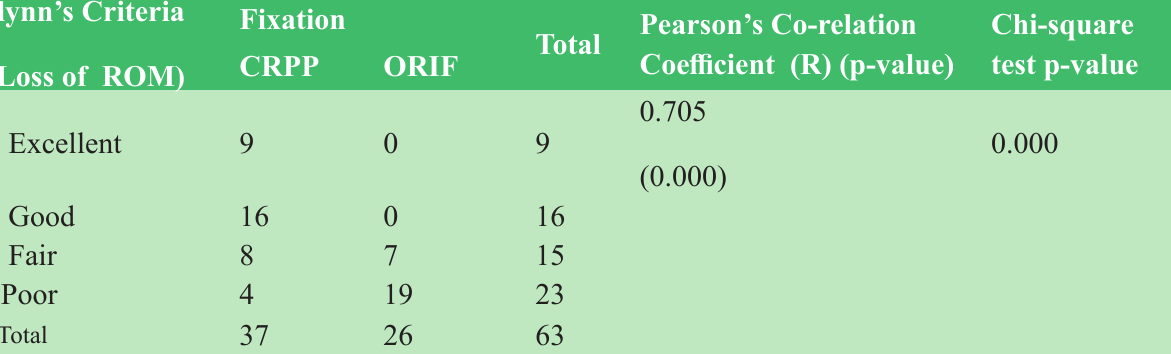
Table 4: Outcome According To Flynn’s Criteria and Type of Fixation Flynn’s Criteria